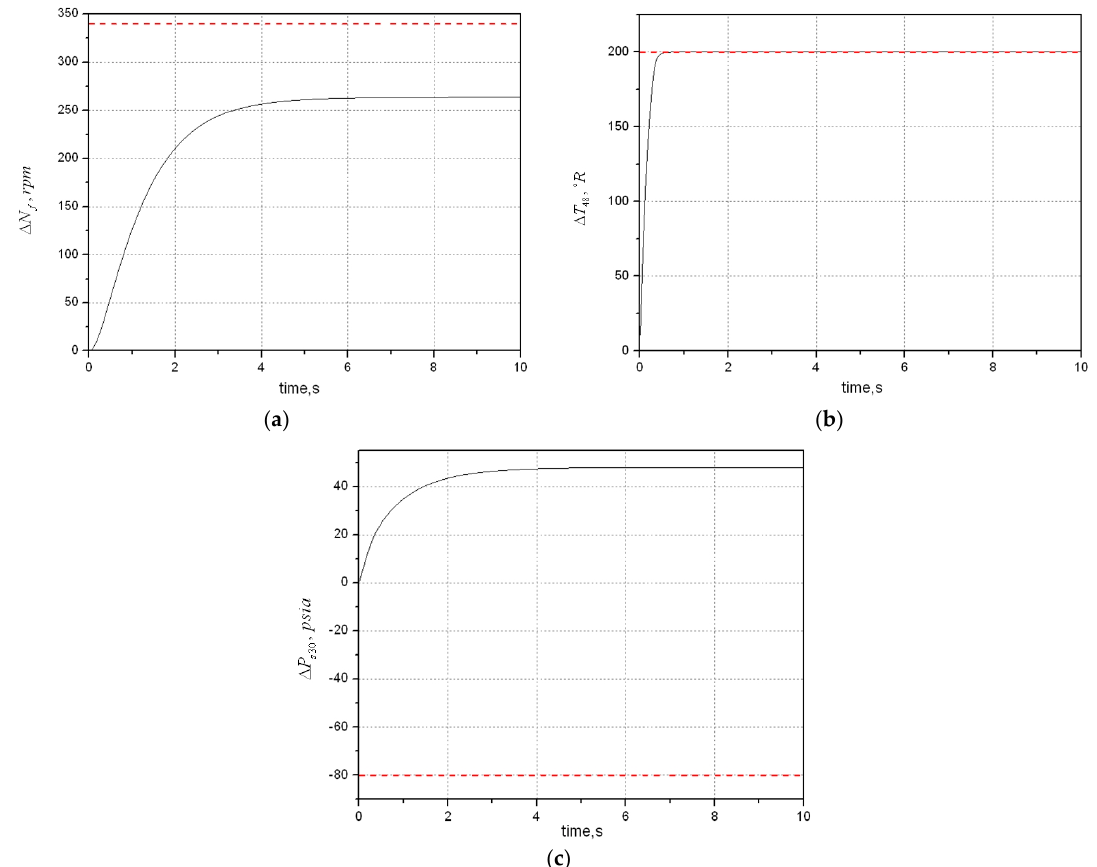
Figure 9. Output response with OAMTC limit regulator: positive set-point change. ( a ) Fan speed response; ( b ) high-pressure turbine outlet temperature response; and ( c ) high-pressure compressor outlet static pressure response.